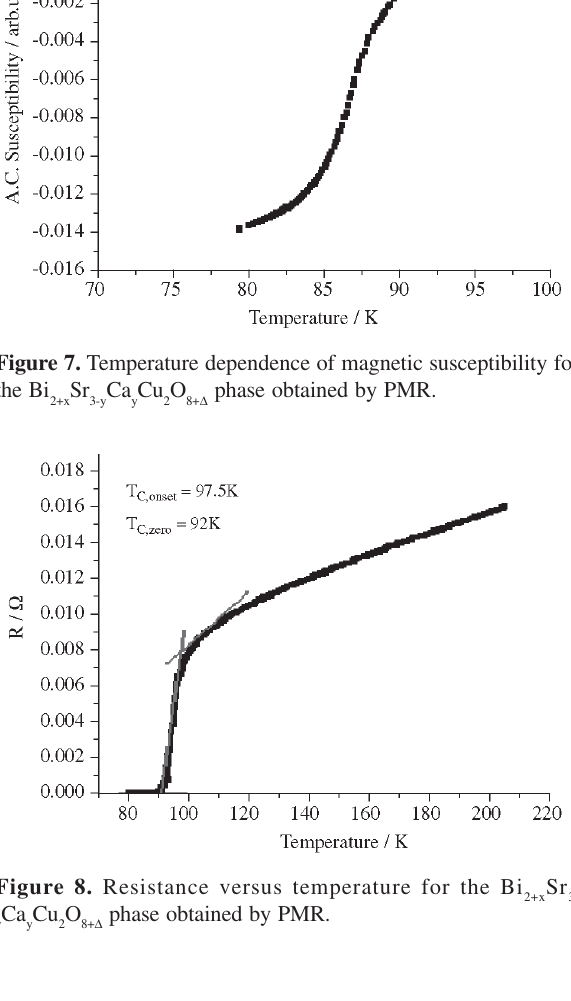
Cu O PMR. The non-zero voltage at the low currents observed at 14 24 41 Fig. 9 is an experimental artifact due to thermal drift effect.